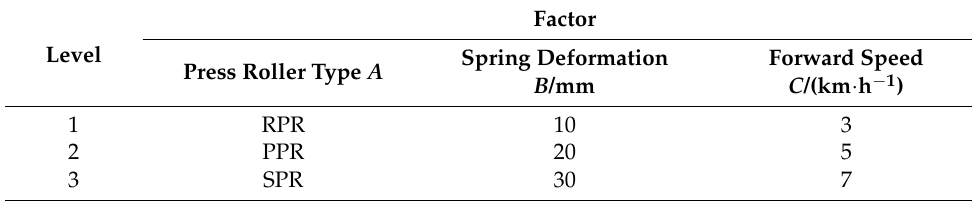
Table 2. Factor coding and experimental levels.